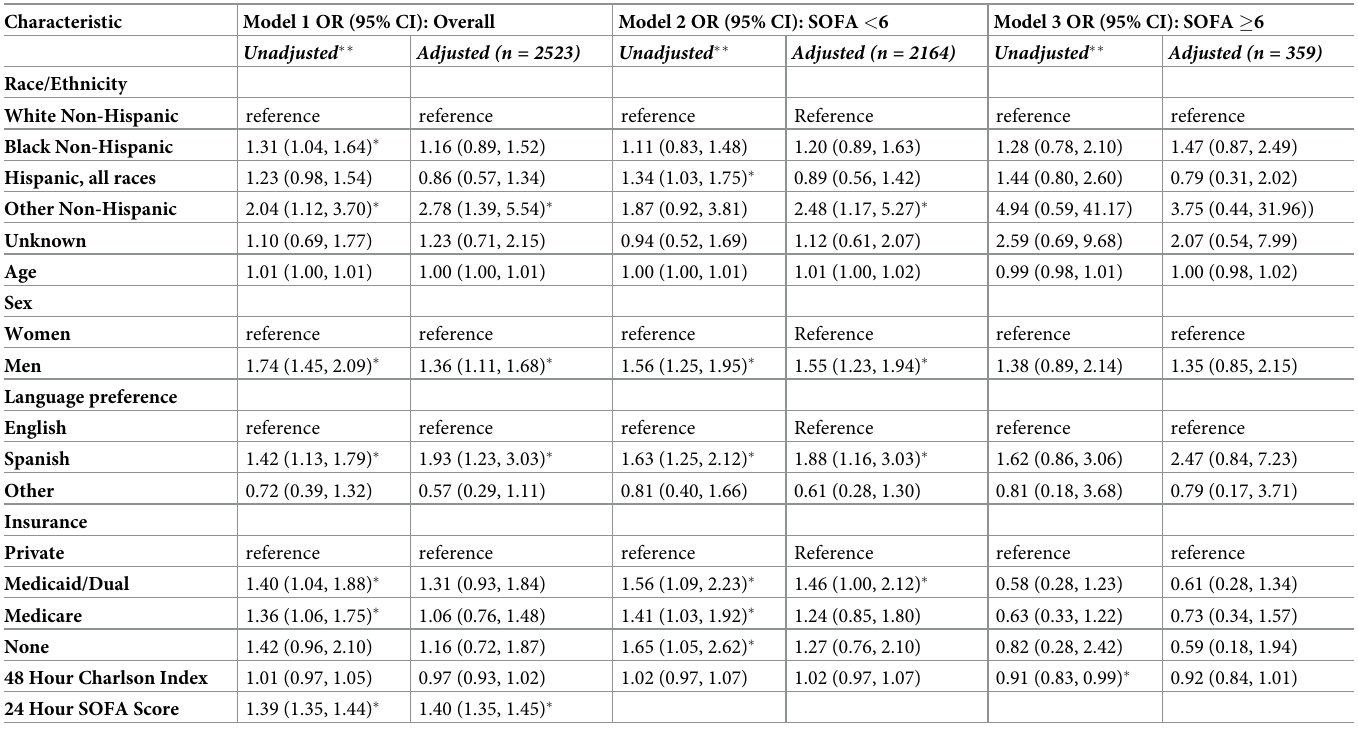
Table 4. Factors associated with ICU admission, stratified by 24-hour SOFA score ��� .